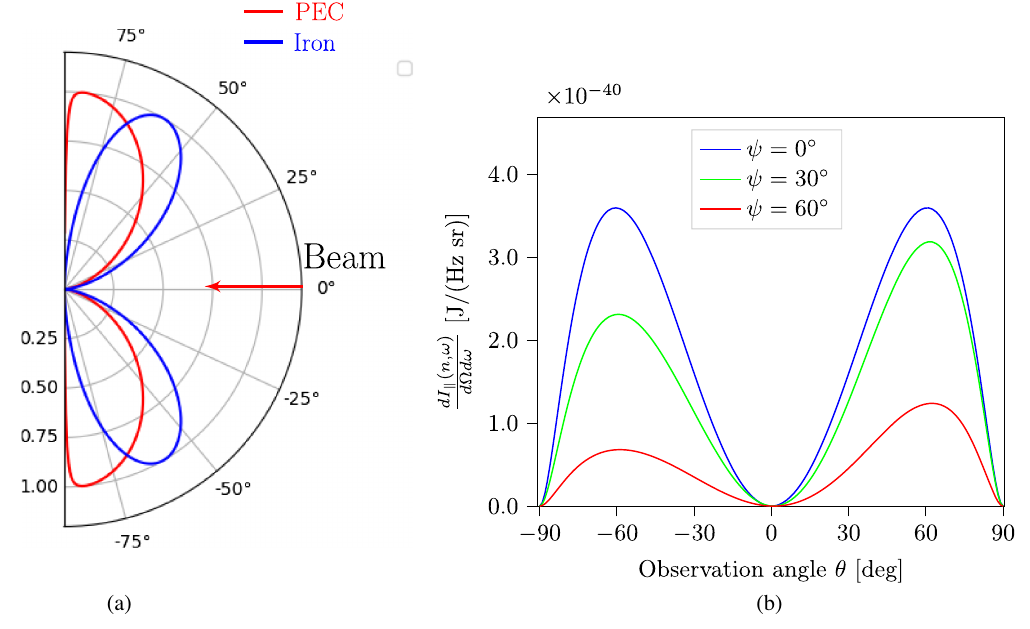
FIG. 2. (a) Polar plot showing the angular distribution of transition radiation emission from an iron target in comparison to perfect electric conductor (PEC) when irradiated by a singly charged particle with velocity β ¼ 0 . 15 at ψ ¼ 0 °. (b) The angular distribution of intensity for an iron target when irradiated at different